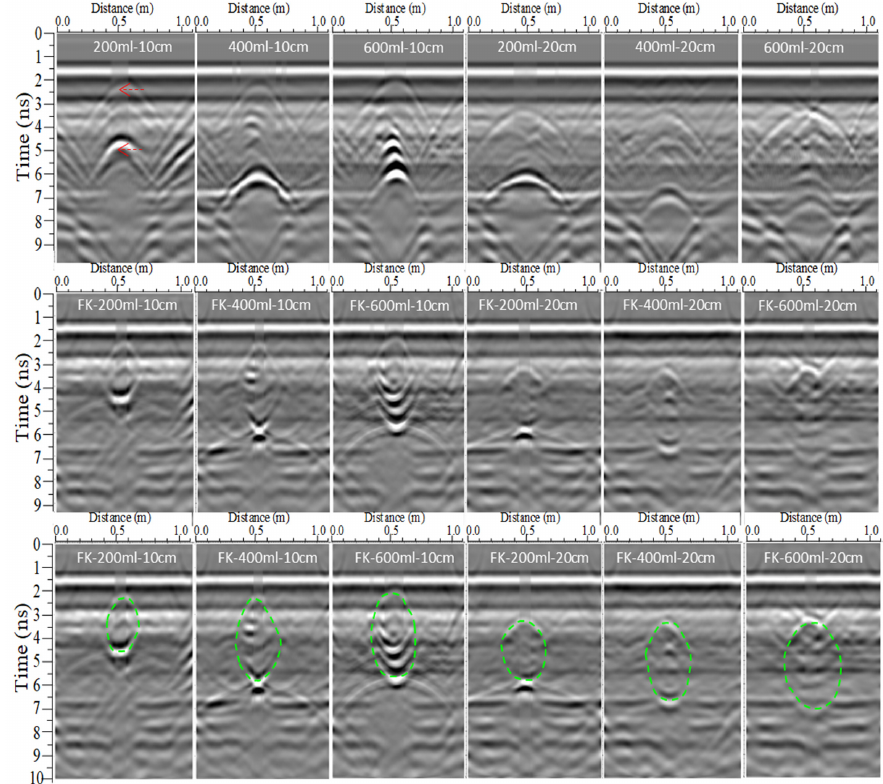
Figure 13. Radargrams of a subsurface bubbler irrigation SWB. The first line is the raw GPR radargram of the SWB with different irrigation volumes and depths, named “irrigation volume–depth.” The second line is the FK migration results of the first line, named “FK-irrigation volume–depth.” The third line is the FK radargram of the SWB, with a rough outline of said SWB (green dotted line).